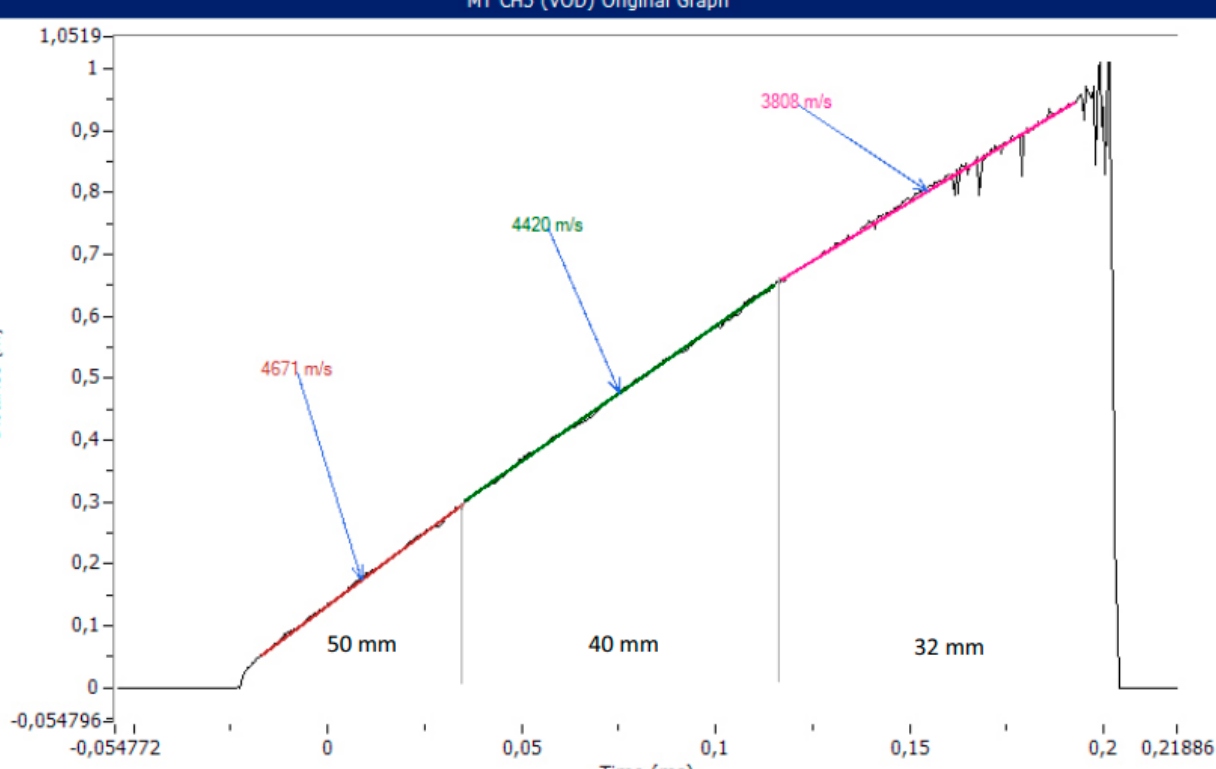
Figure 1. The influence of charge diameter on the velocity of detonation plot for an Emulinit 8 L sample tested in a sewage pipe of varying diameter. Reprinted with permission of the Łukasiewicz Institute of Industrial Organic Chemistry from [13].